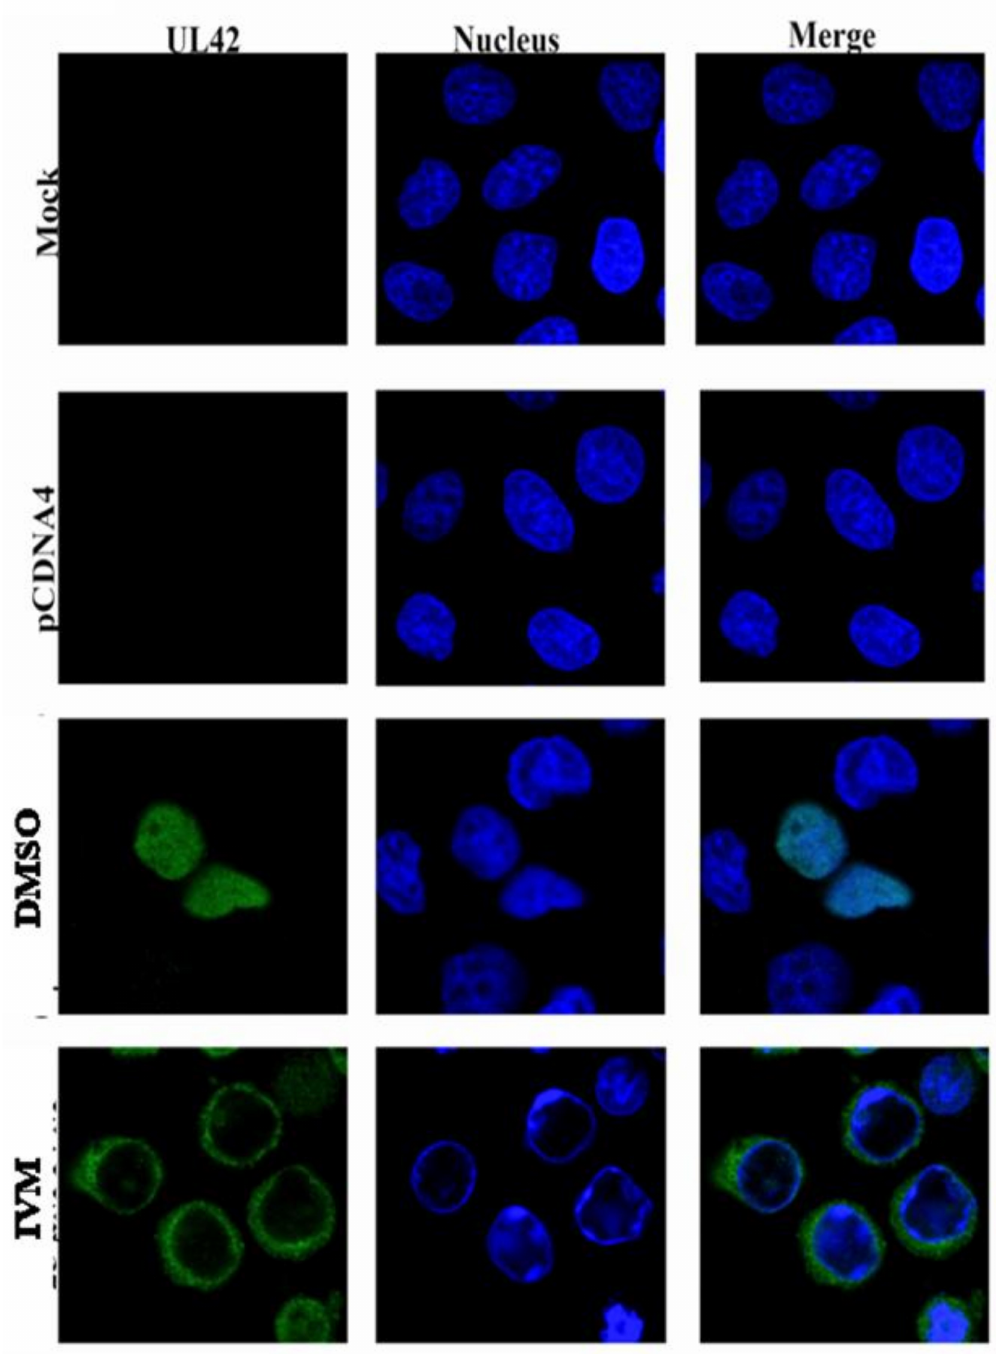
Figure 3. IVM impairs nuclear localization of BoHV-1 pUL42.MDBK cells were transiently transfected with pcDNA4-UL42-FLAG in the presence and absence of IVM (25 µ M), processed for in situ immunofluorescence and subjected to CLSM analysis at × 63 magnification objective using an anti-FLAG monoclonal antibody. The pUL42 protein is shown in green (FITC); the nucleus is shown in blue (DAPI); and merged images of the two channels are shown on the right